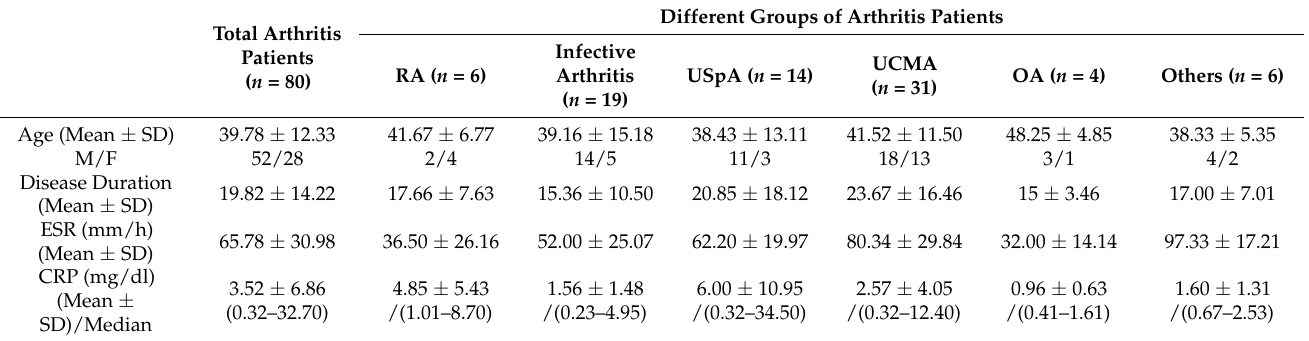
Table 1. Clinical and demographic features of